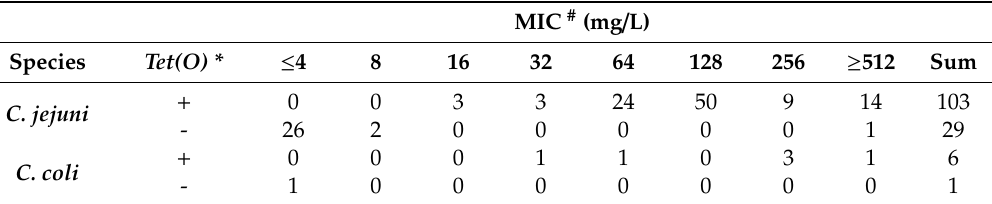
Table 1. Involvement of tet (O) in tetracycline